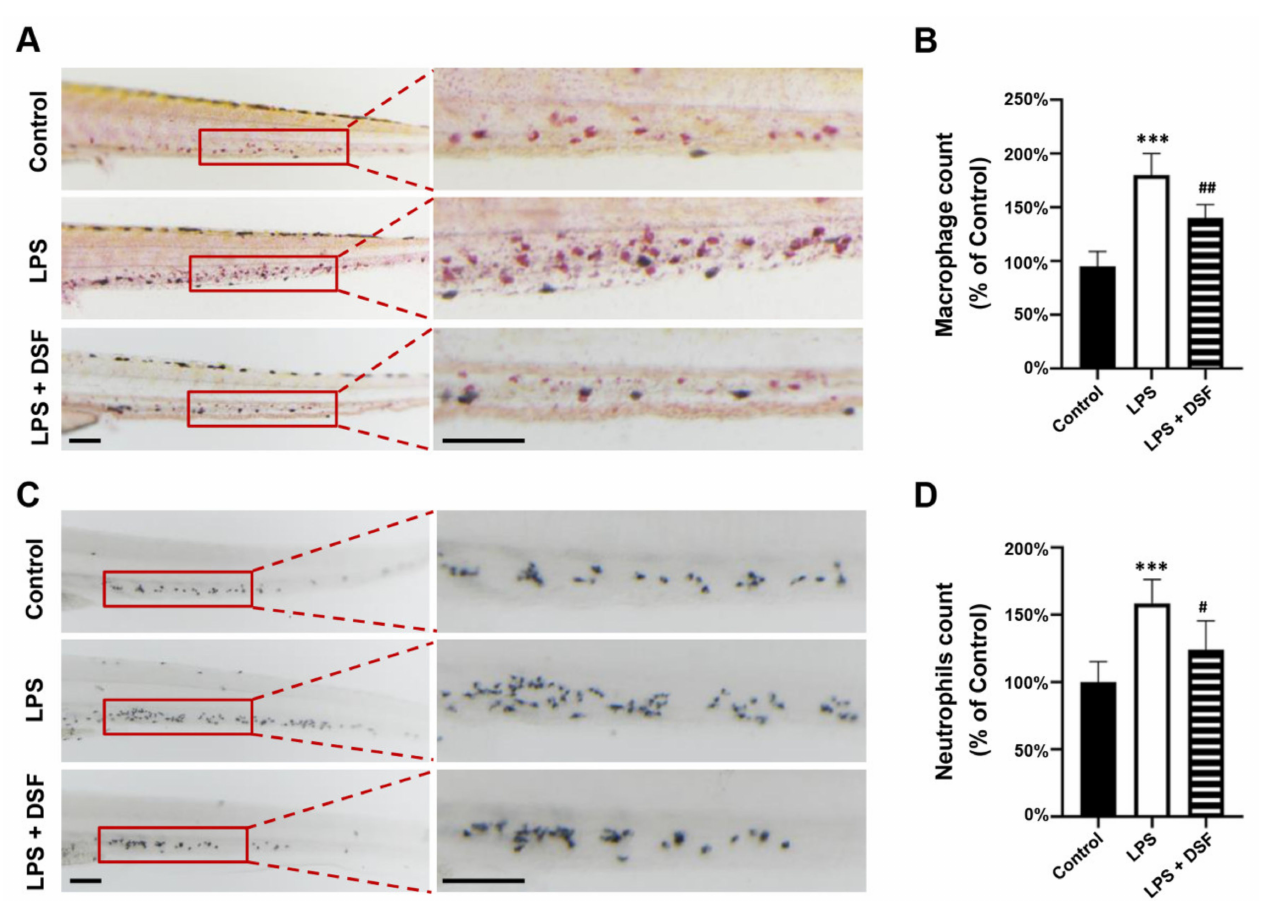
Figure 3. DSF prevented LPS-induced accumulation of macrophages and neutrophils in zebrafish embryos. ( A ) The macrophages were labeled with Neutral red staining. ( B ) Quantitative analysis of macrophages in the same area (red boxes) in A. ( C ) The neutrophils were labeled with Sudan Black B staining. ( D ) Quantitative analysis of neutrophils in the same area (red boxes) in C. Data are represented as mean ± S.D. *** p < 0.001 vs. control group; # p < 0.05, ## p < 0.01 vs. LPS group. Scale bar, 100 µ